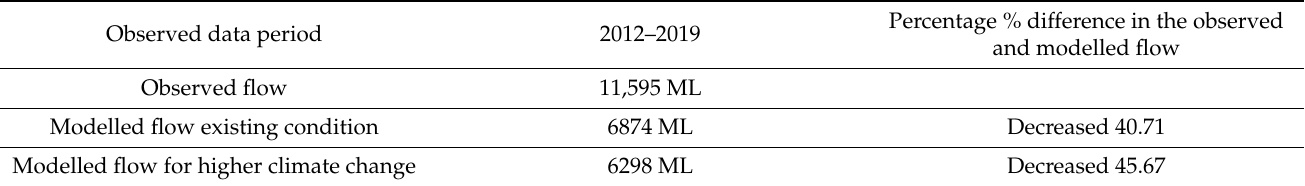
Table 11. Before and after climate change water quantity result.